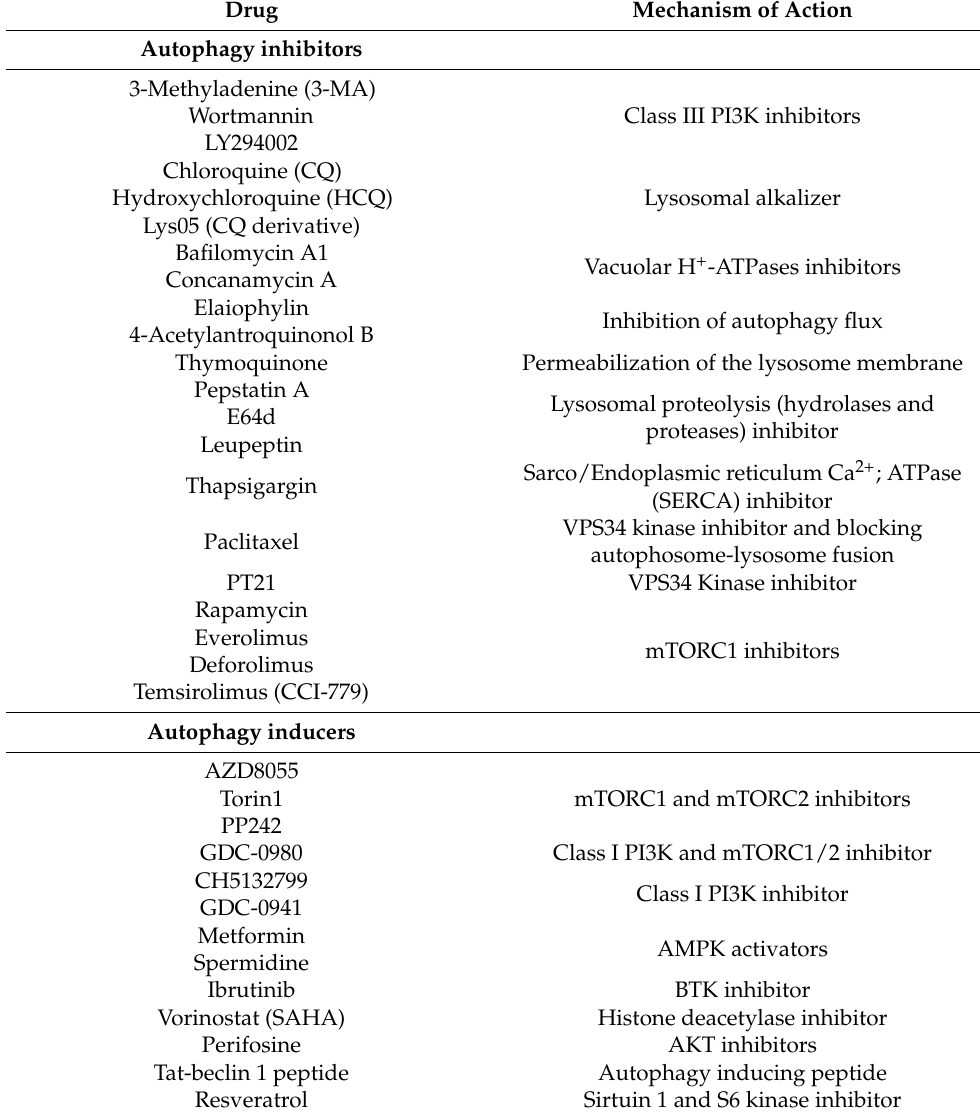
Table 2. Mechanism of action of the most prominent autophagy inhibitors and